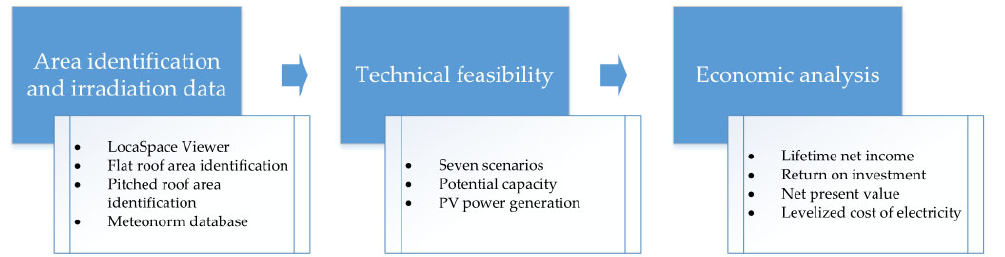
Figure 1. The methodology flowchart in this